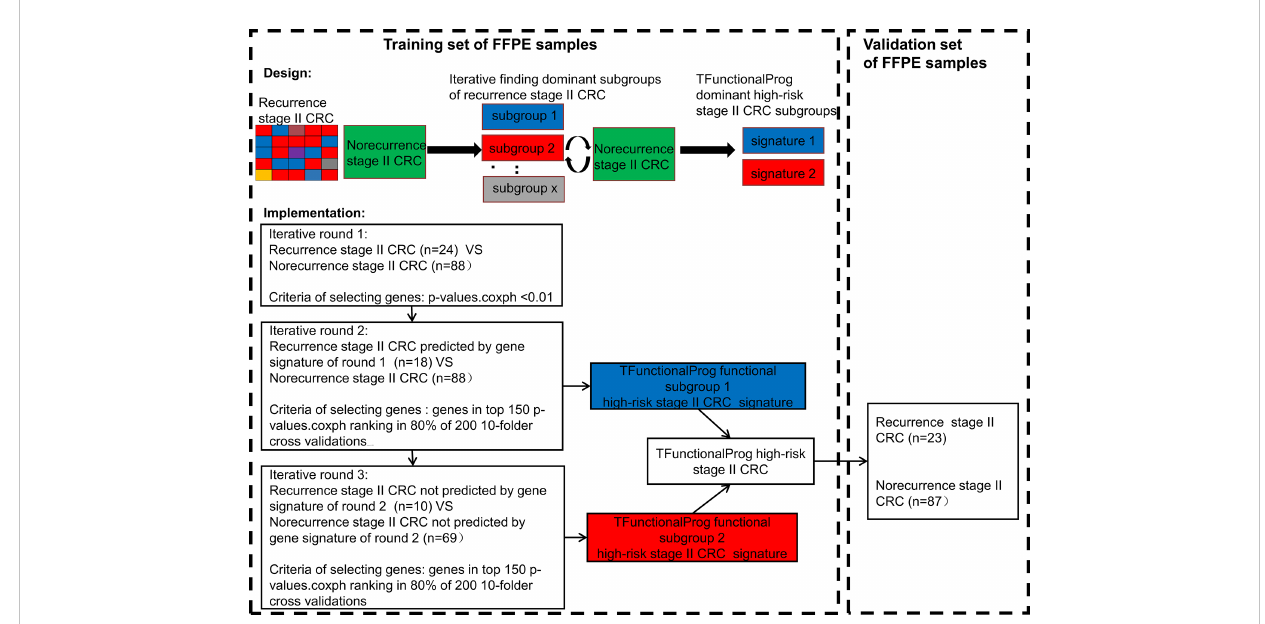
FIGURE 1 The implementation of the TFunctionalProg method dissects stage II colorectal cancer patients with recurrence into two subgroups, and then analyzes the mechanism of recurrence of the two subgroups